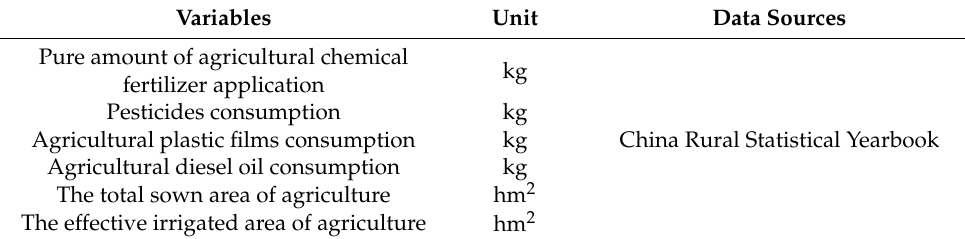
Table 1. The data sources.